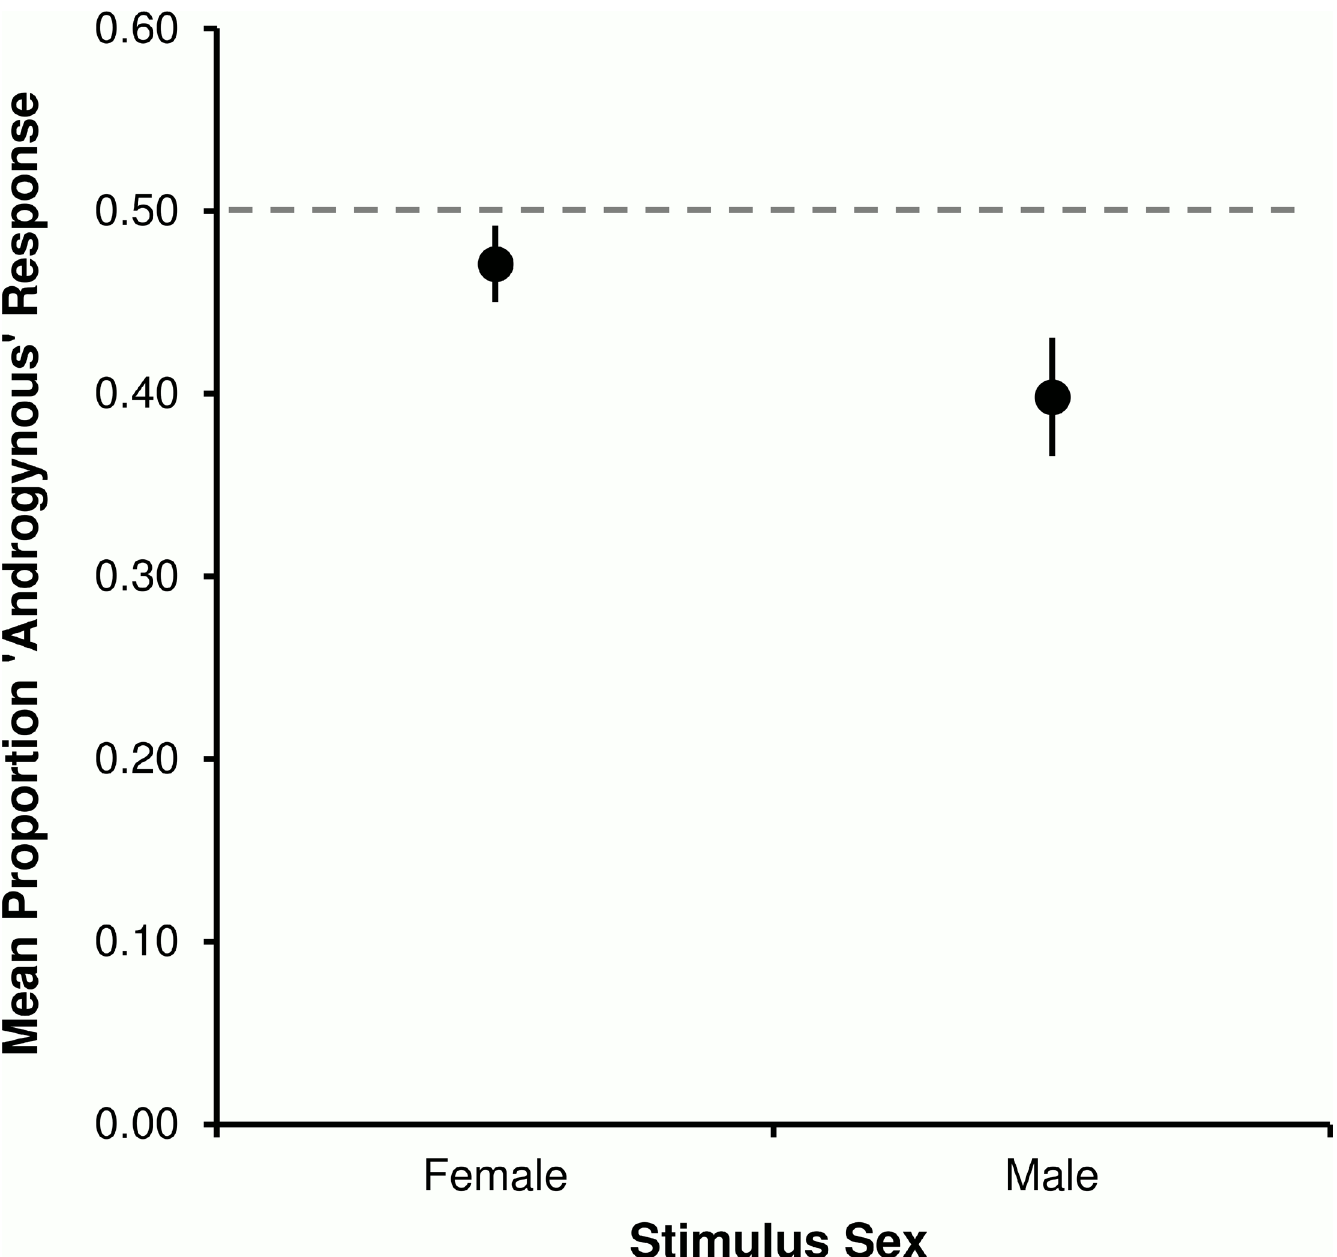
Fig 9. Average rate of reporting silhouette face profiles as androgynous. Data are plotted as a function of stimulus sex (female and male), and were averaged across four stimulus exposure times (125 ms, 250ms, 500ms, and 1000 ms). The horizontal dashed line represents the rate expected by random responding; vertical lines represent ± 1 SEM